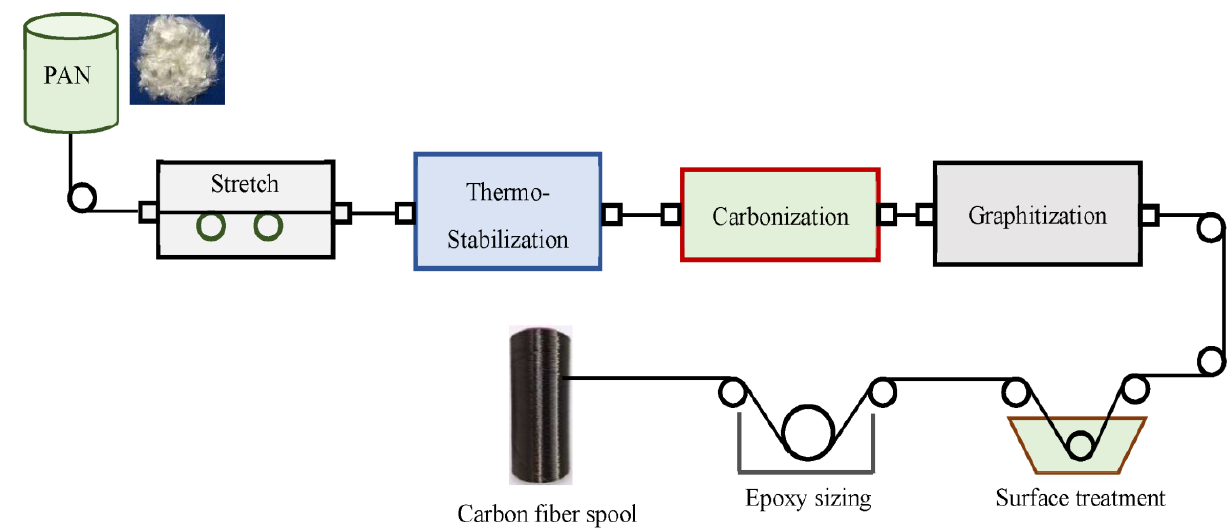
Figure 2. Carbon fiber production using PAN precursor.